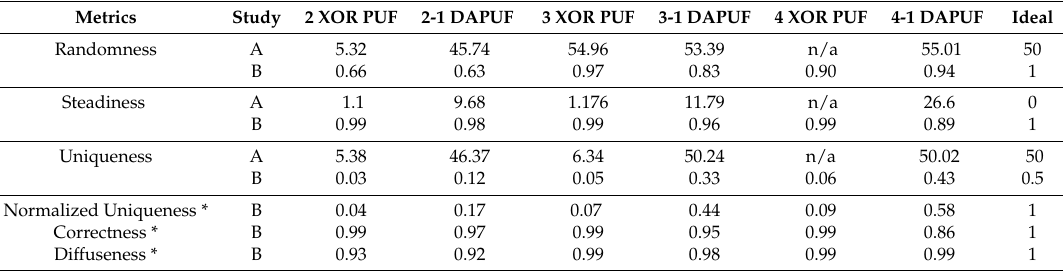
Table 3. Performance evaluation results for both XOR PUF and DAPUF